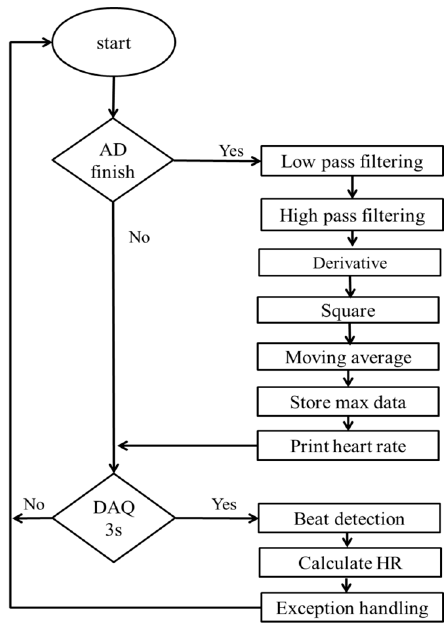
Figure 7. Flowchart for ECG signal processing.